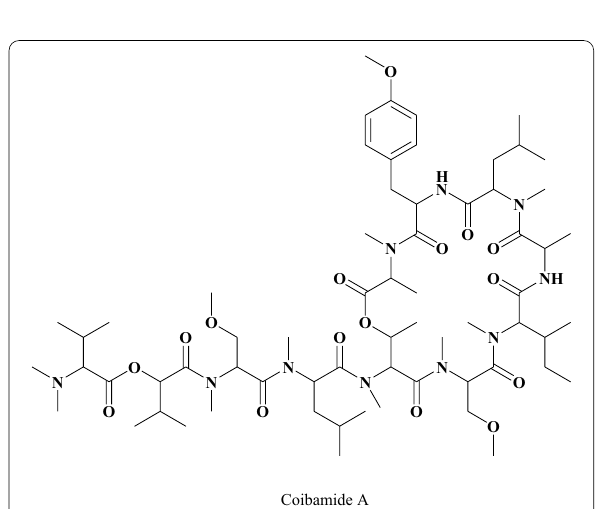
Fig. 4 Chemical structure of an marine Leptolyngbya cyanobacterium derived Coibamide